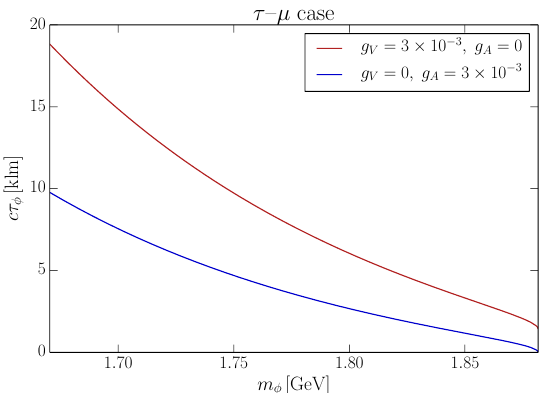
Figure 8 . The decay length of φ in the τ − µ case. The red line corresponds to g V = 3 × 10 − 3 and g A = 0 , while the blue line does to g V = 0 and g A = 3 × 10 − 3